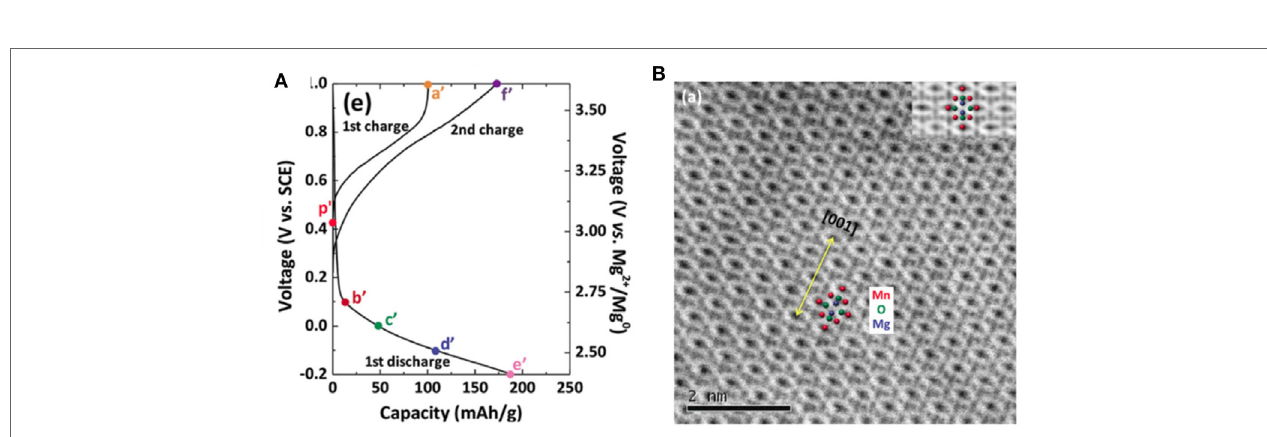
FigURe 5 | (A) Electrochemical responses of the Pt/1 M Mg(NO 3 ) 2 /acid-treated spinel Li x Mn 2 O 4 cell. (B) ABF-STEM image of the acid-treated spinel. Atomic positions are marked as Mn (red), O (green), and Mg (blue). Reprinted with permission from Kim et al. (2015a). Copyright 2015 WILEY-VCH Verlag GmbH & Co. KGaA, Weinheim.